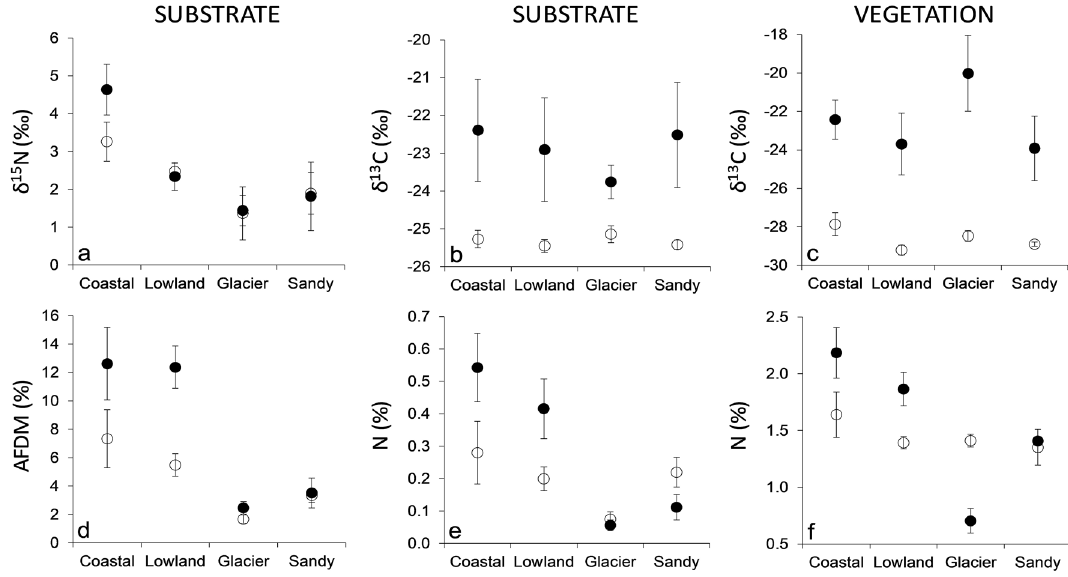
Figure 3. δ 15 N, δ 13 C, ash free dry matter as % (AFDM) and N content as % in various lake categories in North Spitzbergen (Svalbard Islands). “Coastal” refers to “ Muddy coastal ” lakes, while “Sandy” refers to “ Sandy coastal ” lakes. “SUBSTRATE” refers to the comparison of sediment (black symbols) and soil (empty symbols). “VEGETATION” refers to the comparison of aquatic vegetation (black symbols) and terrestrial vegetation (empty symbols). Statistics are reported in Table 2.